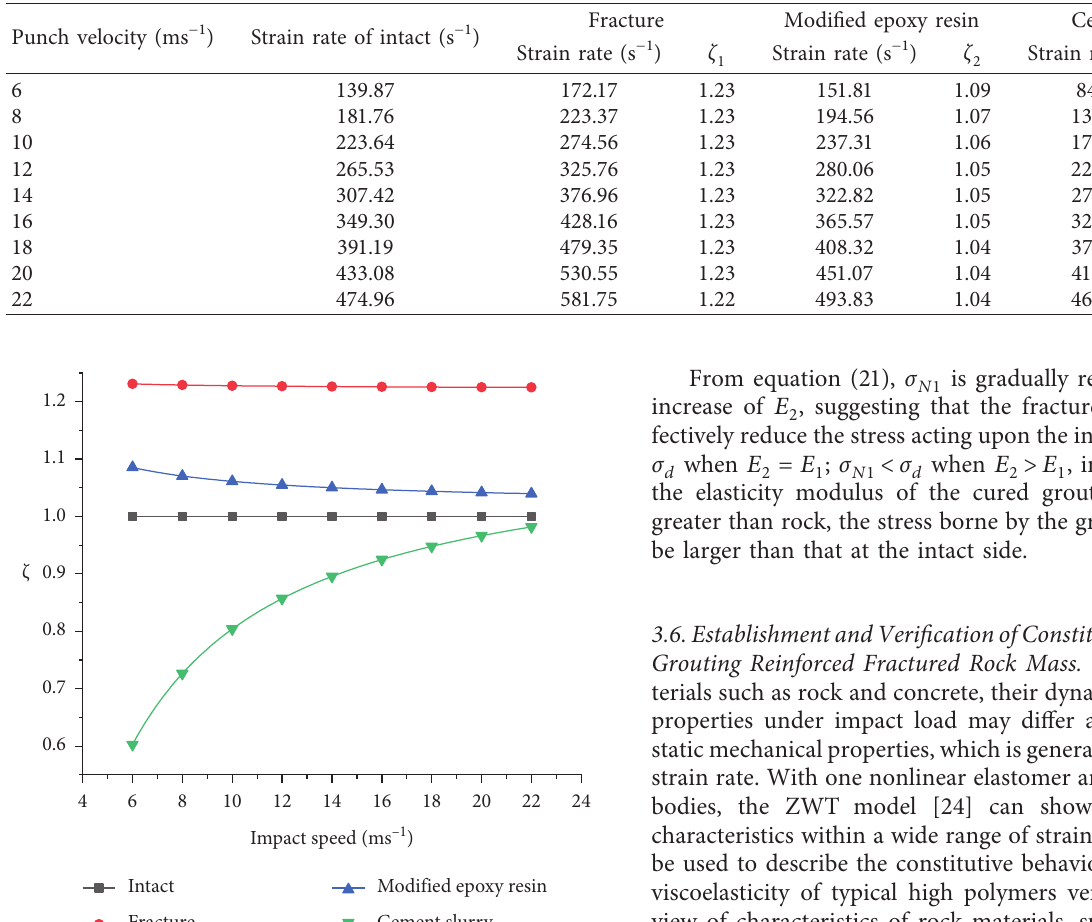
Figure 11: Impact speed-specific strain